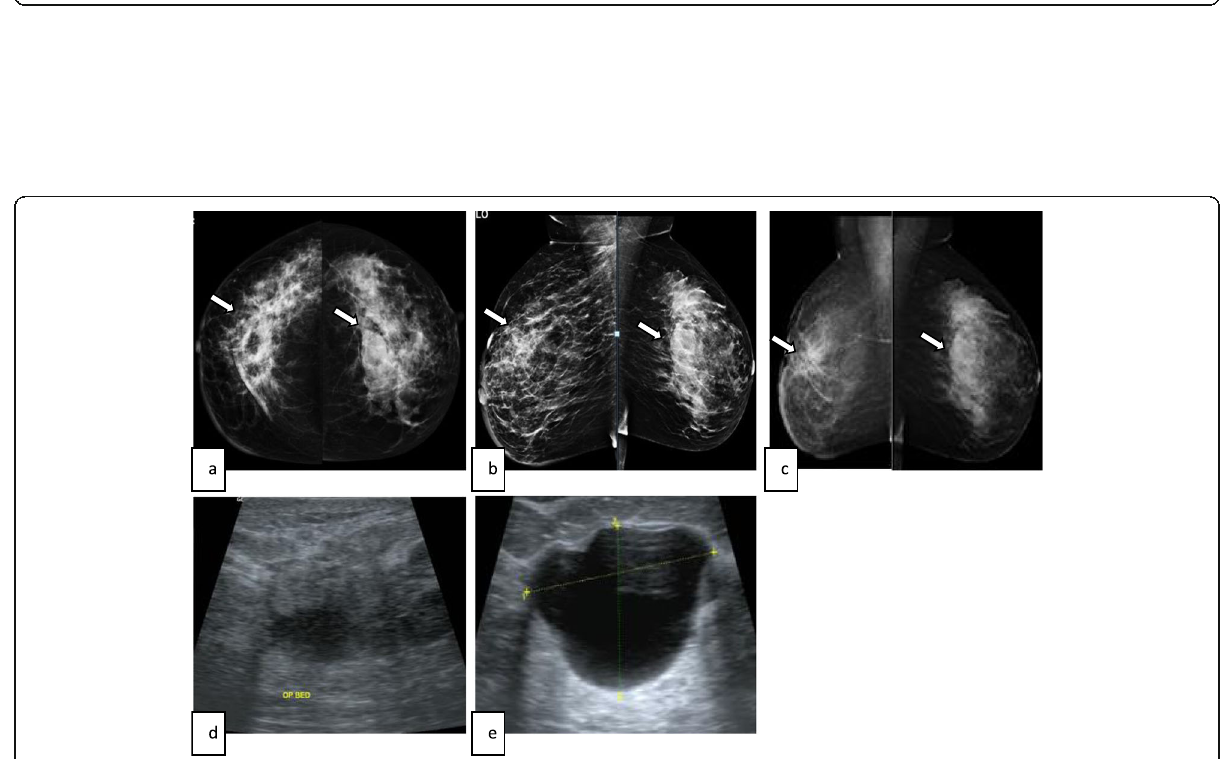
Fig. 9 (Case no. 2) A 58-year-old patient with history of right breast conservative surgery and left mastalgia. Mammography revealed breast density: ACR B, right breast: single-view asymmetry (BIRADS 3) and left breast: global asymmetry (BIRADS 4) ( a and b show CC and MLO views, respectively). 3D tomosynthesis was inconclusive in both sides ( c MLO view). Breast ultrasound revealed: right breast: operative bed architecture distortion (BIRADS 2) ( d ) and left breast: well-defined thin wall hypoechoic cyst with posterior enhancement (BIRADS 2) ( e ). Final diagnosis: right breast postoperative changes and left breast fibrocystic